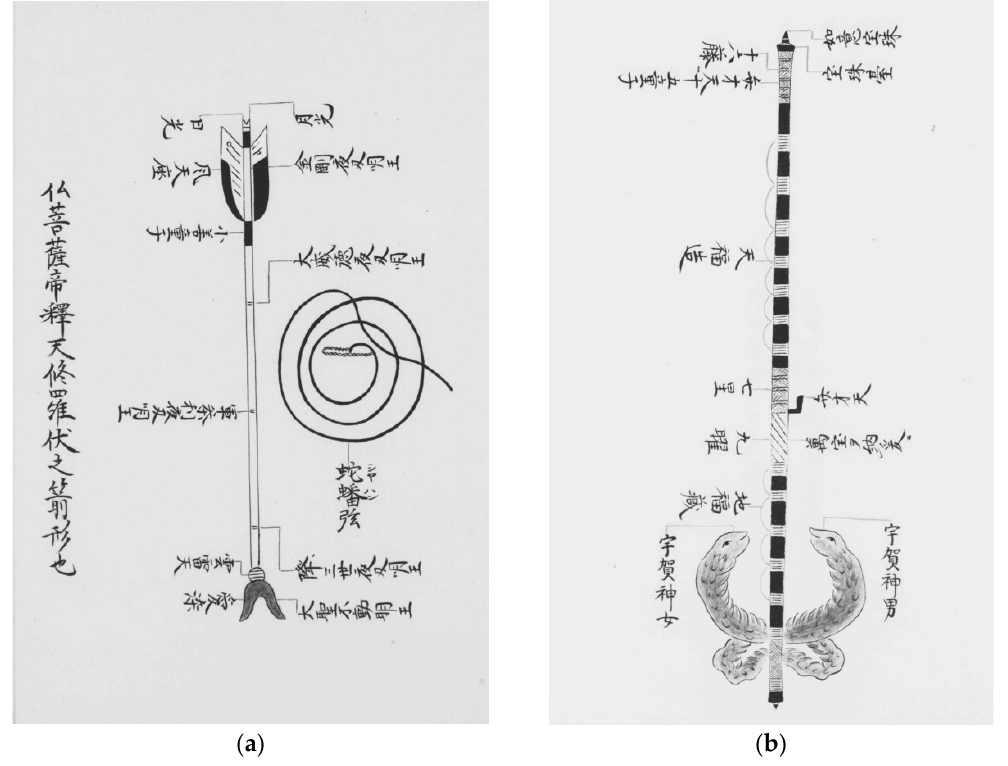
Figure 2. Bow and arrow. Takeda-ry ū yumitsuruya no zu no maki (Scroll Containing Images of the Bow, String, and Arrow [Transmitted in] the Takeda-Ry ū , 1704). ( a ) Image of the arrow used with the jagy ō ky ū (musk-deer bow), of which the forked arrowhead is associated with Fud ō and Aizen’ ō . ( b ) Image of the fukuz ō ky ū (fortune-making bow), showing two Ugajin serpent deities at the bottom. Courtesy of the K ō chi Castle Museum of History.